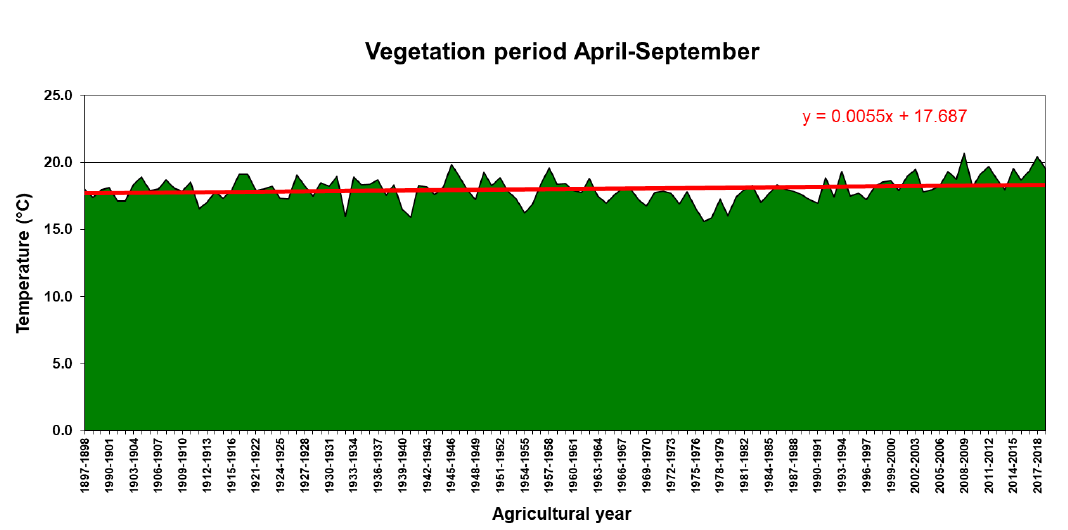
Figure 3. Temperature evolution during vegetation period recorded in the Banat Plain, at the Regional Meteorological Center Banat-Crisana during the period 1897 – 2019.